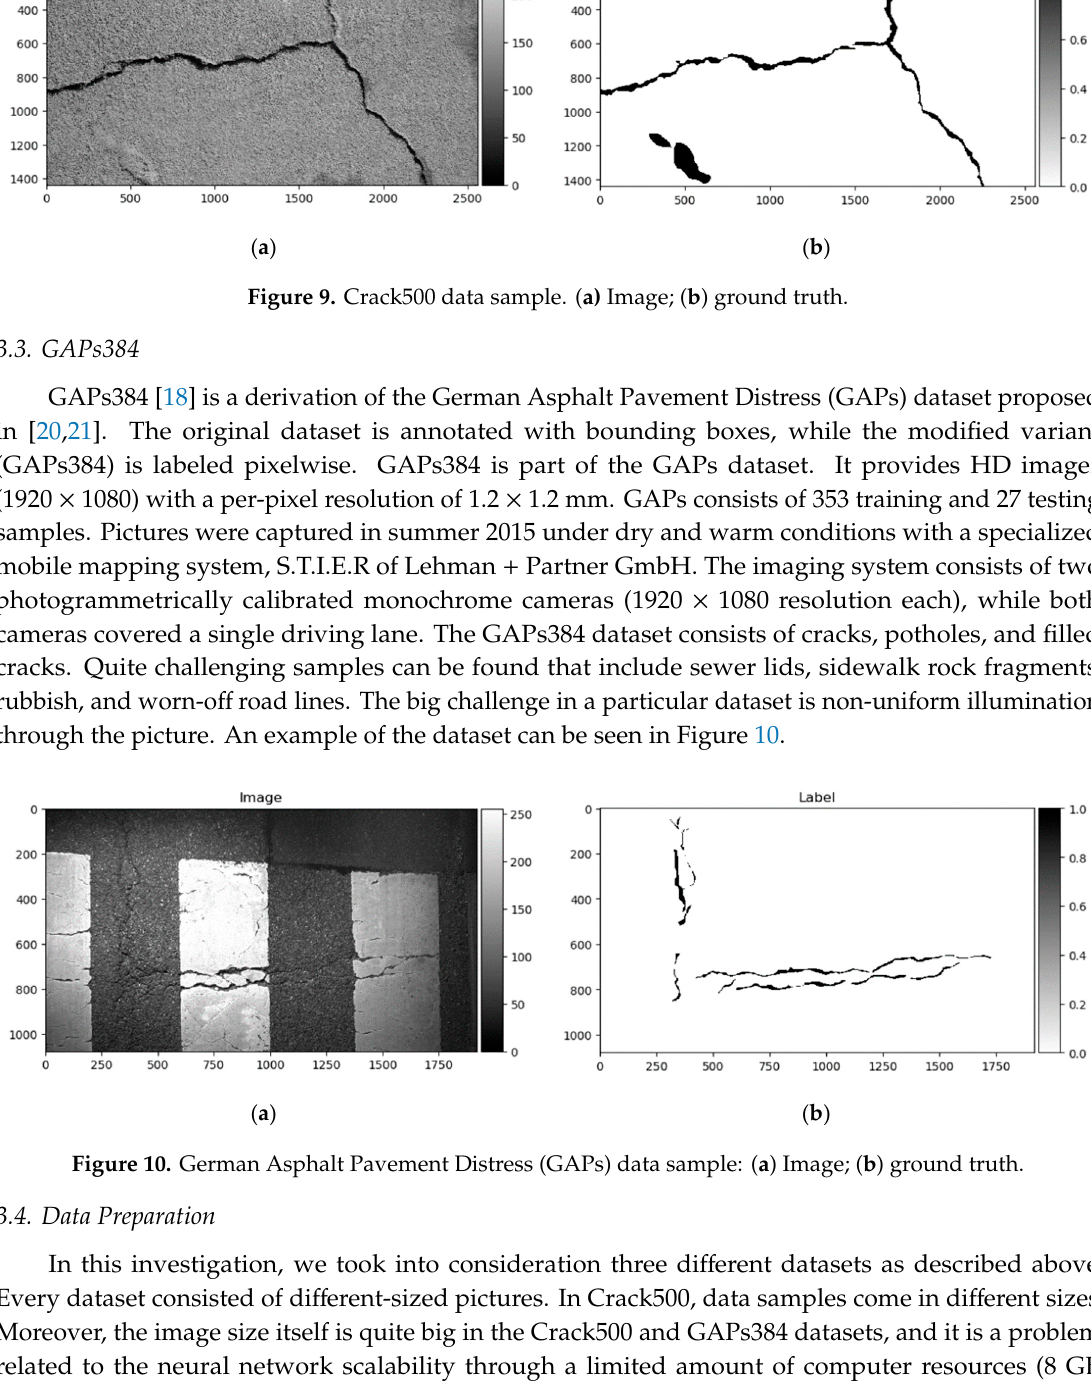
( b ) Figure 8. CrackForest data sample. ( a ) Image; ( b ) ground truth. Multiple researchers from all over the world used this dataset to practice crack detection, and, according to the researchgate.net portal, the citations of the CrackForest database [16] exceed 108 publications. The variety of applied methods goes from simple rule-based methods [49] to moderate image processing by edge detection [50] or superpixel [51] techniques and histogram features [52] to advanced deep learning-based methods for crack detection [53]. Method evaluation differs from author to author by the used evaluation metrics and strategies, depending on article goals. Some authors proposed to use the tolerance distance from 2 to 5 pixels to overcome data-labeling inaccuracy [14]. The best published results are summarized in Table 1. Table 1. Best results on CrackForest dataset. Authors